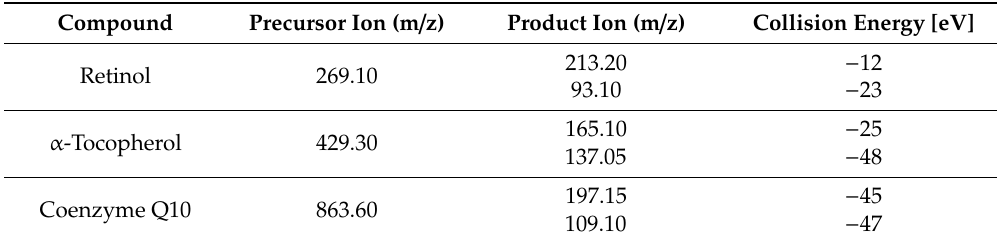
Table 1. Conditions for generating positive ions of